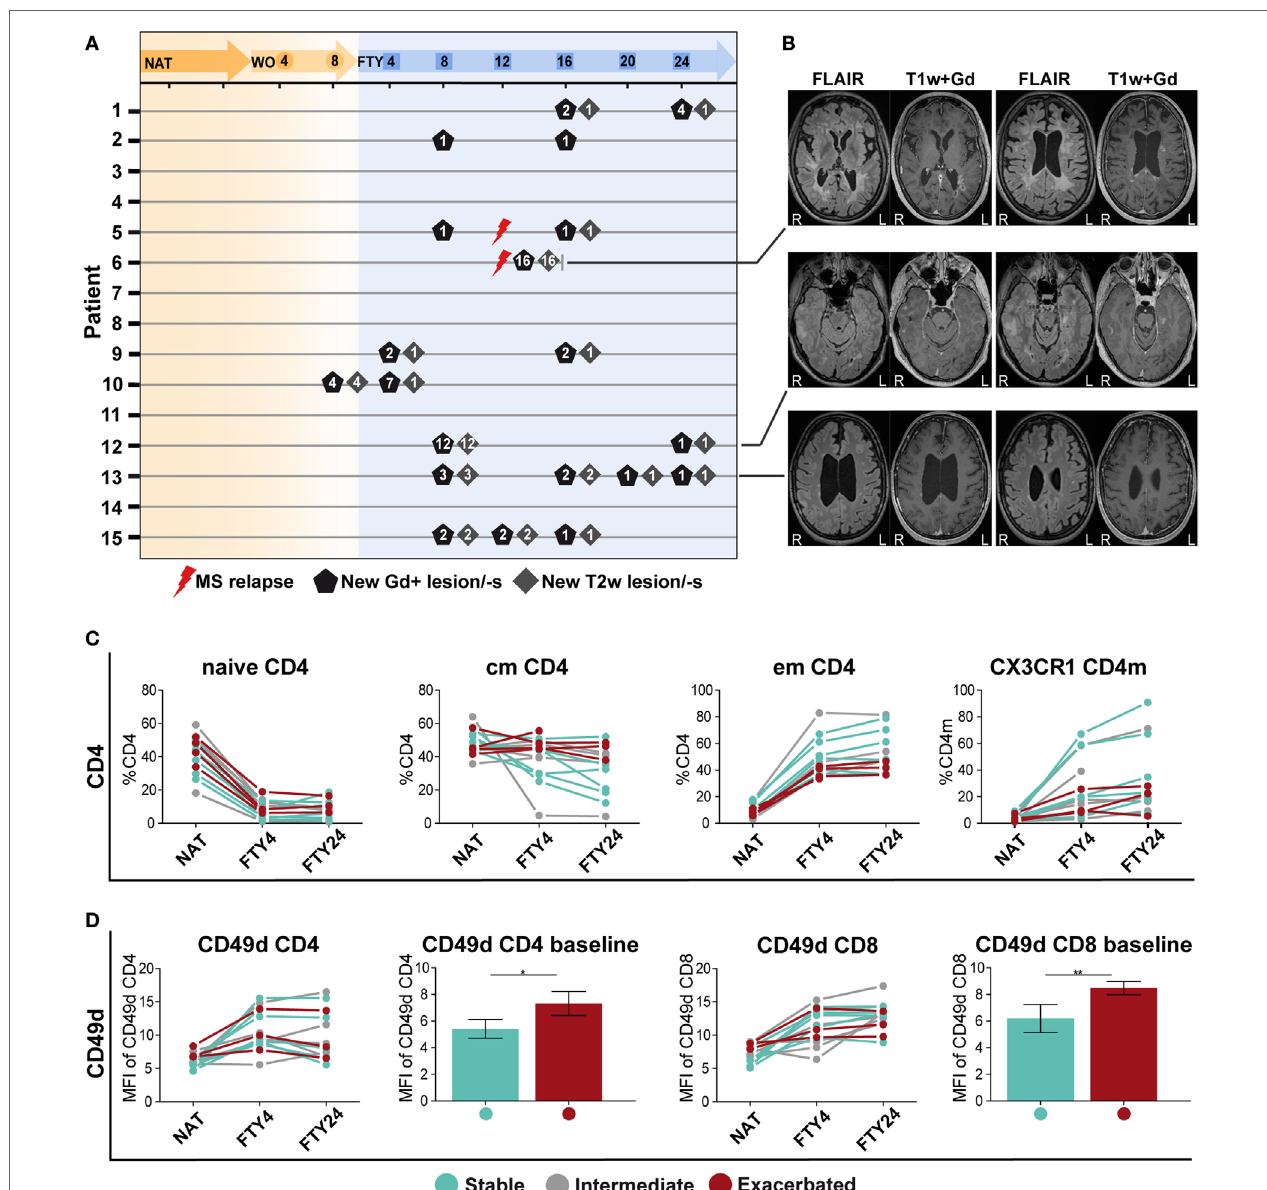
FigUre 4 | Patients with a stable disease course exhibit significantly reduced CD49d expression levels under long-term natalizumab (NAT) treatment. (a) MR imaging was performed at baseline under long-term NAT treatment (NAT), after 8 weeks of washout without treatment (WO) and at weeks 4, 8, 12, 20, and 24 after onset of fingolimod (FTY) treatment. Numbers of new gadolinium-enhancing (Gd + )-lesion/-s (black pentagon), T2w-lesion/-s (gray square), and clinical multiple sclerosis relapses (red flash) are presented per patient and time point. (B) Examples of the MRI sequences FLAIR and T1-weighted after intravenous gadolinium- DTPA injection (T1w + Gd) of patients no. 6, 11, and 13 who were defined as “exacerbated” are displayed (R = right; L = left). To assess correlation of peripheral immune signatures with clinical response, the study cohort was divided into subgroups: stable (blue; n = 6), intermediate (gray; n = 5), and exacerbated (red; n = 4 time point NAT and FTY4; n = 3 time point FTY24) estimated by clinical criteria. (c) Comparison of population frequency (%) between baseline long-term NAT treatment (NAT), at time points 4 weeks (FTY4) and 24 weeks (FTY24) after onset of FTY treatment, in CD4 T cell subsets, and CX3CR1 + CD4 memory (CD4m) T cells are shown. (D) MFI of CD49d expression on CD4 and CD8 T cells at indicated time points illustrated in scatter plots and direct comparison of CD49d CD4 and CD8 between stable and exacerbated patients at baseline shown in bar graphs. Values represent mean ± SD. Statistical significance was evaluated by Wilcoxon matched-pairs signed rank test. * P ≤ 0.05; ** P ≤